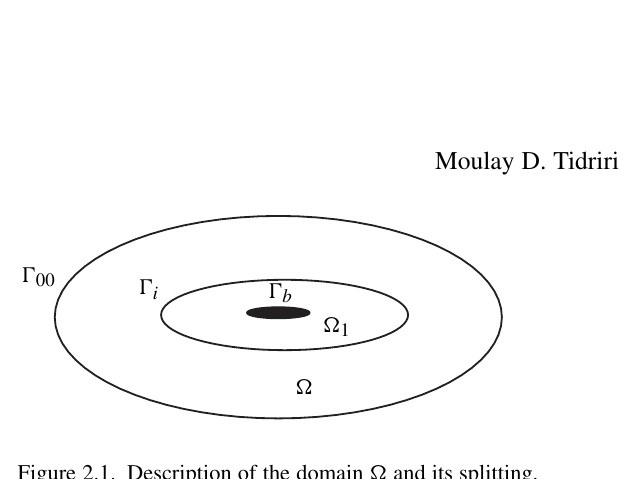
Figure 2.1. Description of the domain (cid:1) and its